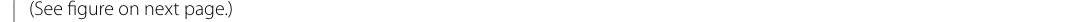
Fig. 1 HBx regulated the expression of diverse lncRNAs in HepG2 cells. a Expression of diverse lncRNAs changed by HBx. b Significantly upregulated (cutoff 3-fold) and significantly downregulated (cutoff 3-fold) lncRNAs. Red or Green color on the heat map indicates a decrease or ≥ ≤ an increase in the lncRNA level and the color intensity corresponds to the relative signal levels on a logarithmic scale. c Nine random lncRNAs were verified by qRT-PCR. Data are normalized to GAPDH and represent the mean SD of three replicate experiments. ENST00000506122 is designated ± lncRNA RP11-241J12.3. d LncRNA RP11-241J12.3 is close to the primary transcript of MSH3 in the genome (magnification